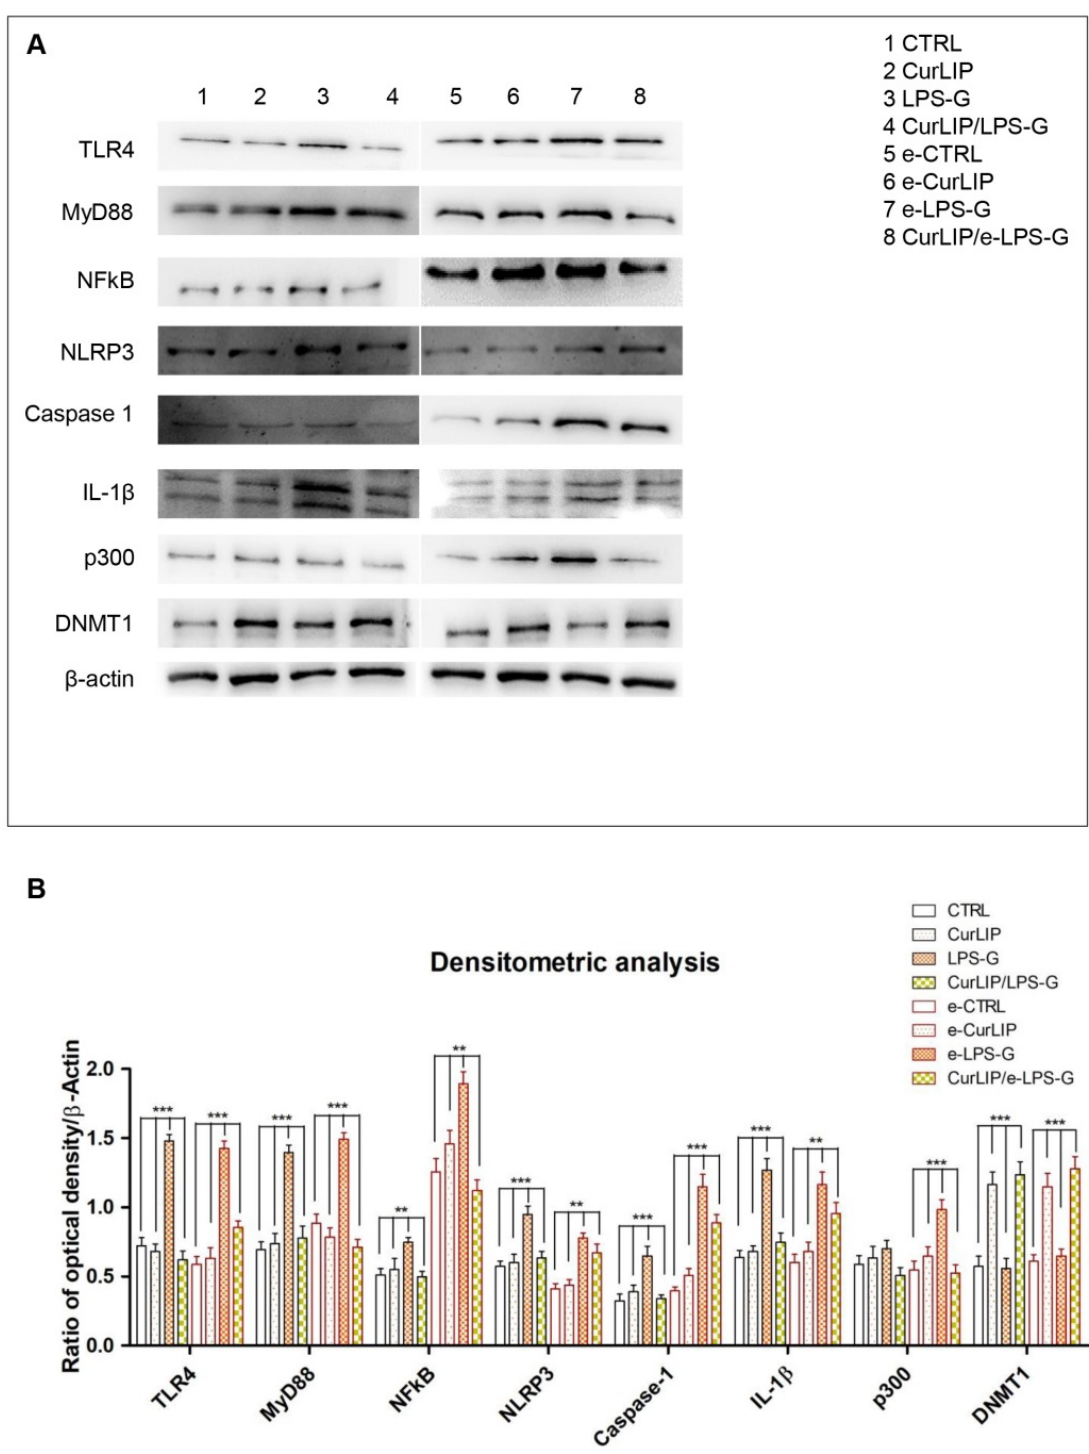
Figure 6. TLR4, MyD88, NFkB, NLRP3, Caspase-1, IL-1 β , DNMT1, and p300 protein quantization in hPDLSCs. ( A ) Protein levels of TLR4, MyD88, NFkB, NLRP3, Caspase-1, IL-1 β DNMT1 and p300 were determined by Western blotting using specific antibodies. ( B ) Relative ratio of TLR4, MyD88, NFkB, NLRP3, Caspase-1, IL-1 β , DNMT1 and p300 normalized with β -actin. *** p < 0.001; ** p < 0.01.